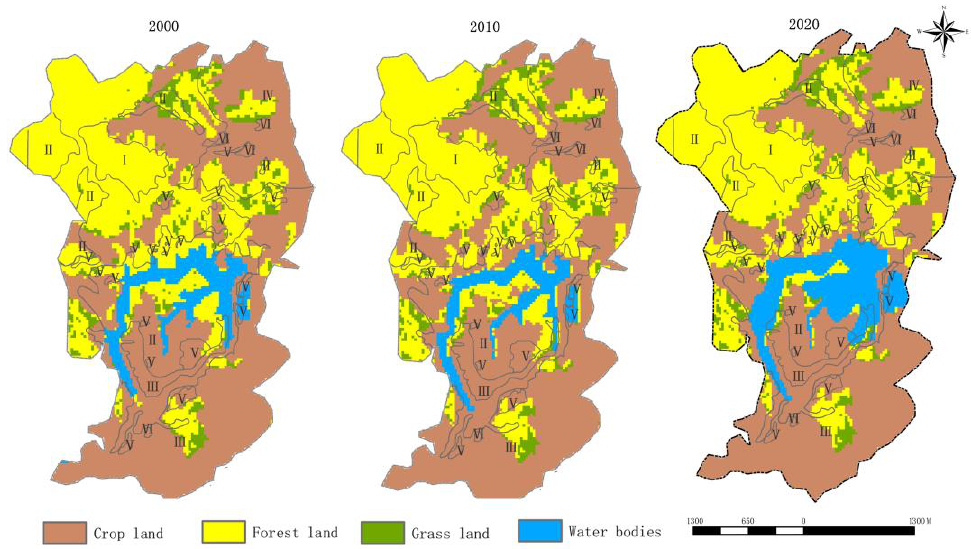
Figure 5. Spatial distribution of land cover in phase iii from 2000 to 2020. Note: I is a special protection zone, II is a scenic tour area, III is a scenic restoration area, IV is a scenic coordination area, V is a tourism service area, and VI is a development control area.